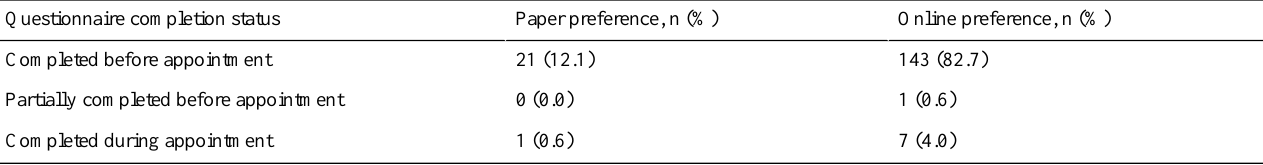
Table 2. Modality preference for questionnaire completion in the EDC a group.